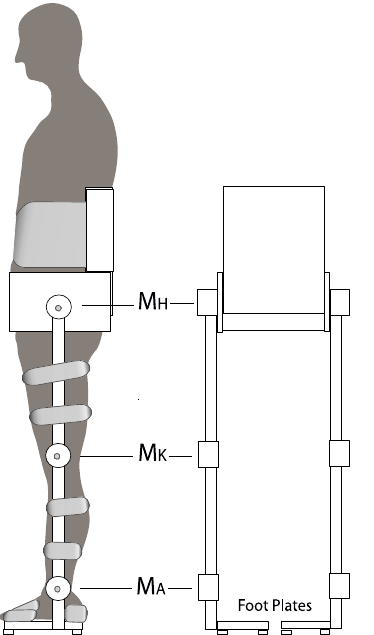
Figure 1. Schematic representation of the suggested powered lower-body exoskeleton. M H , M K and M A , motorized actuators for hip, knee and ankle joints, respectively. The strap from back support over the abdomen reduces trunk bending in the lower vertebral column, whereas trunk bending in the hip joints is essentially unrestrained. Arms used for lifting objects, etc. not shown for simplicity. Further details in Text.